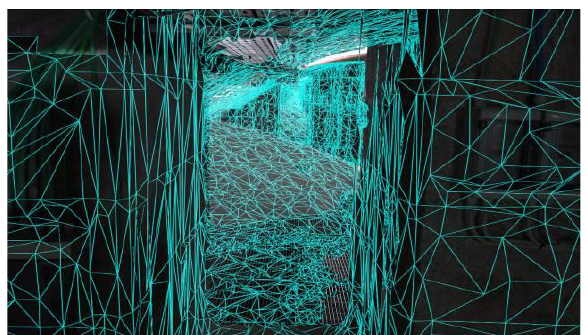
Figure 3. View of the “Sordine” with spatial map